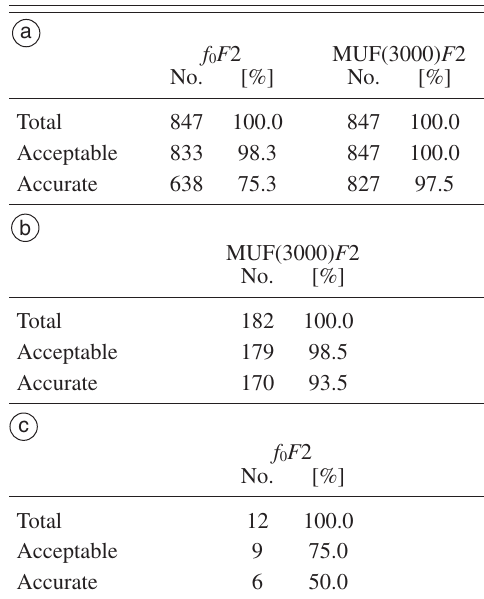
Table IIIa-c. Acceptable and accurate values (with corresponding percentage) for the test carried out on the ionograms recorded in Gibilmanna from Decem- ber 1 to December 15, 2002. In (a) the 847 iono- grams for which the operator was able to scale both f 0 F 2 and MUF(3000) F 2 are considered (subset A ). In (b) the 182 ionograms for which the operator was able to scale only the MUF(3000) F 2 are considered (subset B ). In (c) the 12 ionograms for which the op- erator was able to scale only the f 0 F 2 are considered (subset C ).